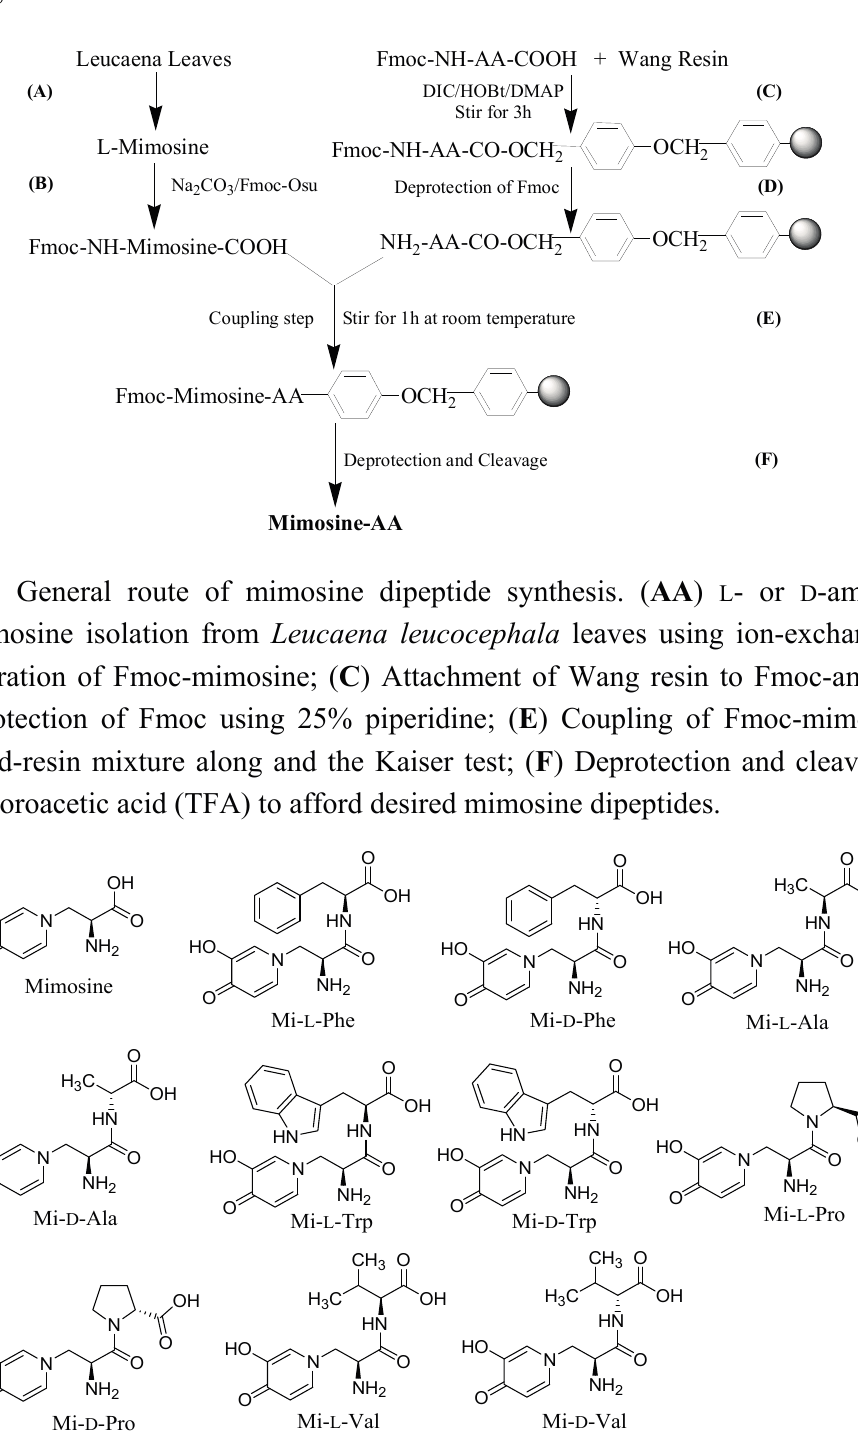
Figure 2. The chemical structures of mimosine and mimosine